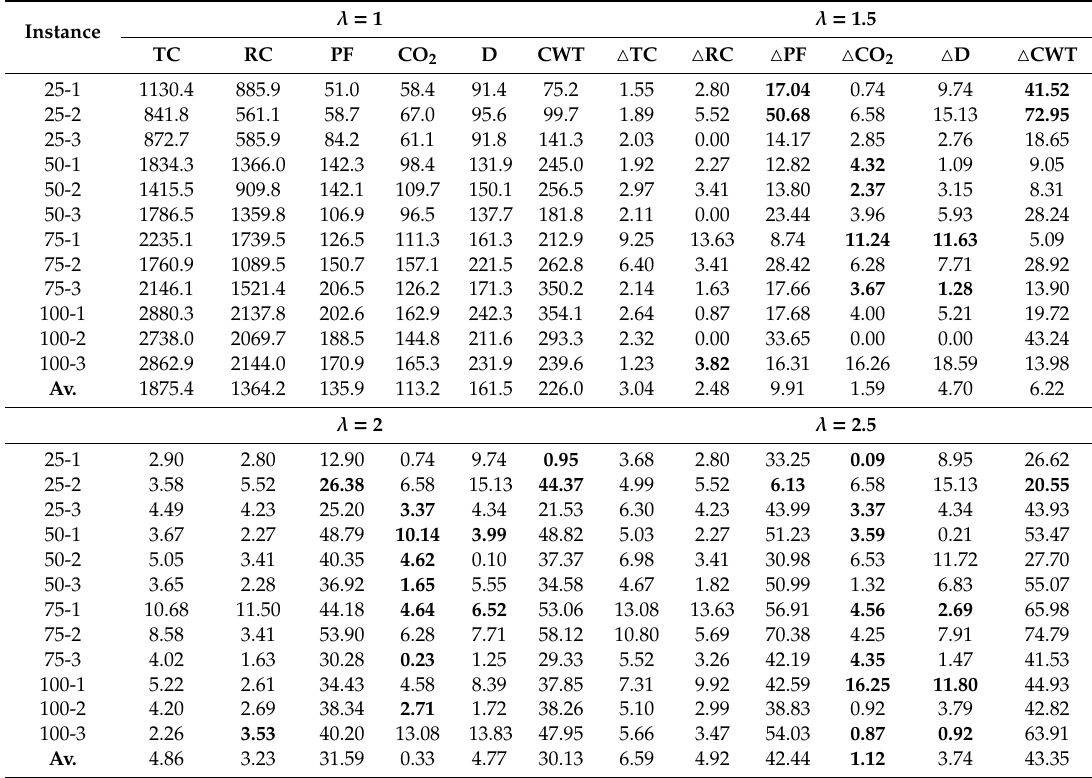
Table 5. Results of LCTW based on four λ